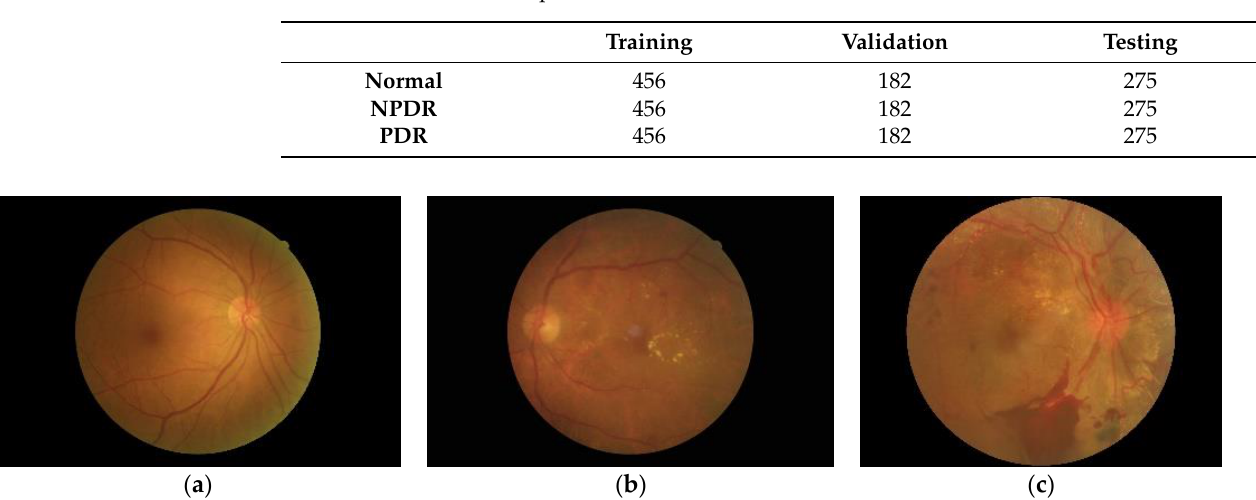
Figure 3. The design of the proposed method. Table 1. DDR dataset composition.